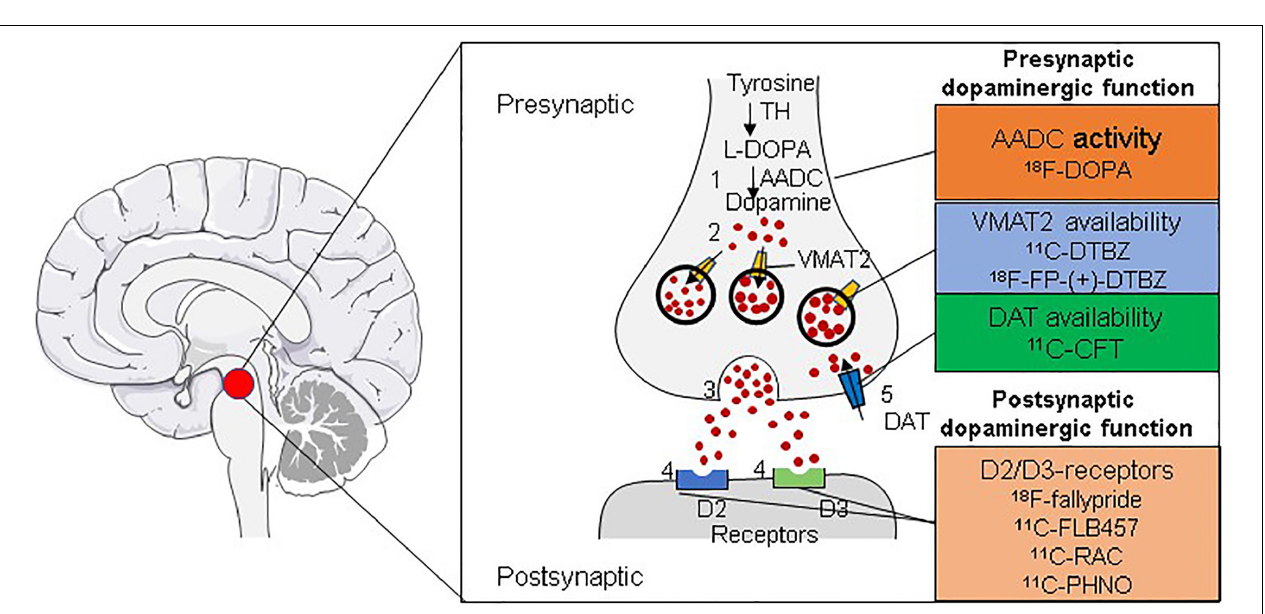
FIGURE 1 | Dual distribution of the vesicular monoamine transporter-2 (VMAT2). VMAT2 is expressed in both β cells (A) and dopaminergic neurons (B) . (A) In pancreatic β cells, VMAT2 can accumulate cytoplasmic insulin in secretory vesicles. (B) VMAT2 is also responsible for accumulating cytoplasmic dopamine in synaptic vesicles in the classical dopaminergic neuron in the central nervous system.